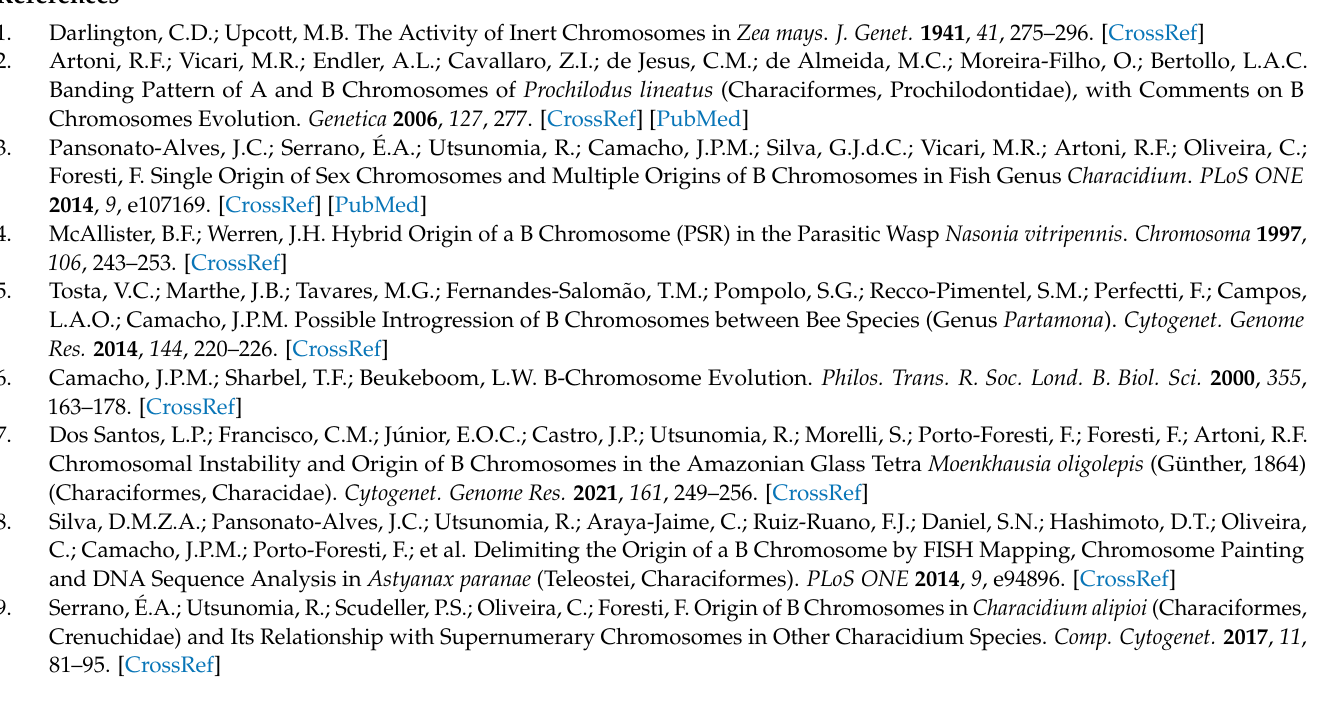
Table S2: Diversity of B chromosomes in Psalidodon